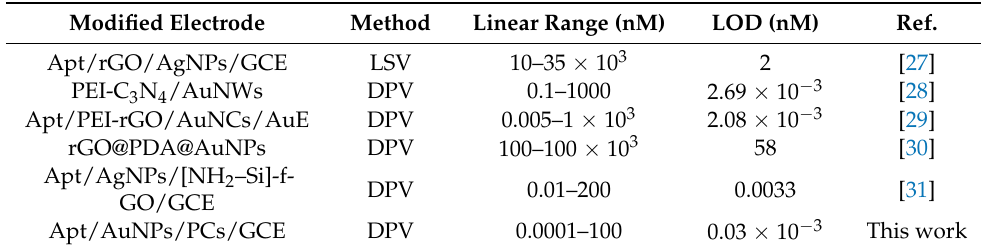
Table 1. Comparison of analytical performance of various reported electrochemical sensors for CAP detection.